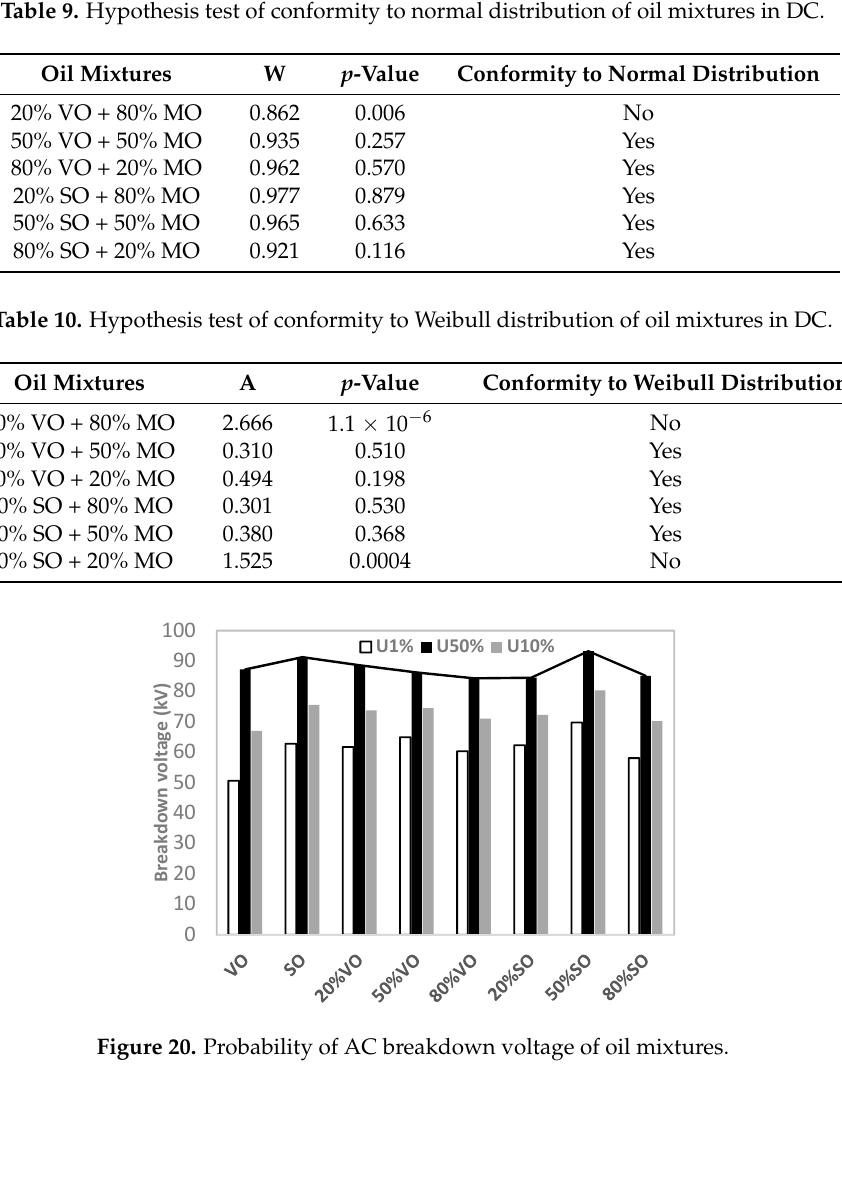
Figure 21. Probability of DC breakdown voltage of oil mixtures. 4. Conclusions This work showed that: Whatever the type of voltage (DC or AC), ester oils always have a significantly higher breakdown voltage than mineral oil. Thus vegetable oil can be used as a satisfactory alternative to mineral oil in power transformers. The mixtures may be an option for improving the performance of mineral oil, from the point of view of dielectric strength. The addition of only 20% of natural or synthetic ester oil is sufficient to considerably increase the breakdown voltage of mineral oil. The dielectric strength of such a mixture is much higher than that of mineral oil alone and can reach that of ester oils. The re-filling of transformers can be considered with mixtures composed of 20% of mineral oil and 80% of ester oil. In the case of vegetable oil, the breakdown voltage of the mixture remains equal to that of natural ester alone. In contrast, when the used replacement oil is synthetic ester, the dielectric strength of the mixture is decreased in comparison with that of synthetic oil. Under AC, the mixtures with natural ester always follow the behavior of vegetable oil alone, unlike mixtures with synthetic ester, which have a breakdown voltage which varies considerably with added concentration up to exceeding that of synthetic oil alone. Under DC, whatever the nature of ester (natural or synthetic), the dielectric strength of mixtures varies as a function of the concentration added to mineral oil and is between that of mineral oil alone and ester oils alone. The breakdown voltage generally follows a normal distribution whatever the oil or mixture. With the exception of the 20% mixture of natural ester in DC, all the tested mixtures were in accordance with the normal distribution, which made it possible to define the breakdown voltages for the risk levels of 1%, 10%, and 50% of probability.